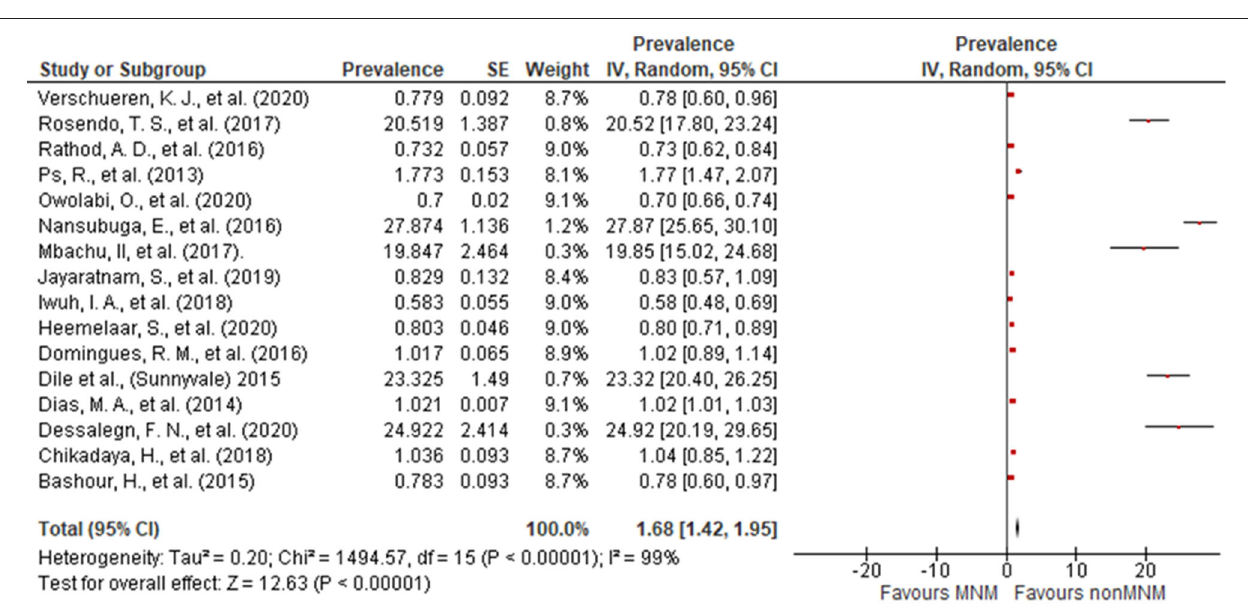
FIGURE 6 | Forest plot depicting the prevalence of maternal near